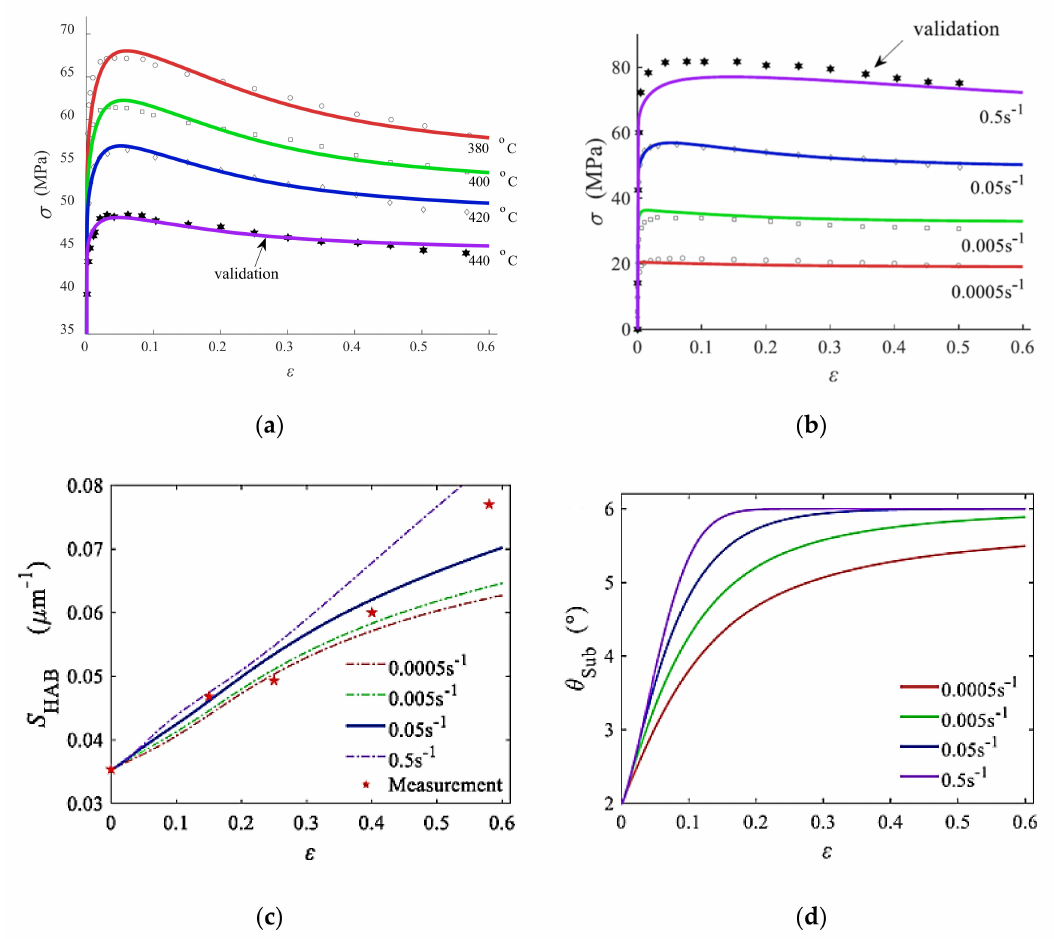
Figure 20. Experimental (symbols) and computed (solid lines) for compression of AA7075: ( a ) stress–strain curves for different temperatures and a constant strain rate of 0.05 s − 1 ; ( b ) stress–strain curves for different strain rates at a constant temperature of 420 ◦ C; ( c ) high angle grain boundary area per unit volume, S HAB , for the conditions in ( b ); ( d ) subgrain misorientations, θ sub , for the conditions in ( b ). Note that the symbols in ( c ) represent the S HAB measured at a strain rate of 0.05 s − 1 and a temperature of 420 ◦ C. (Reproduced with permission from Elsevier